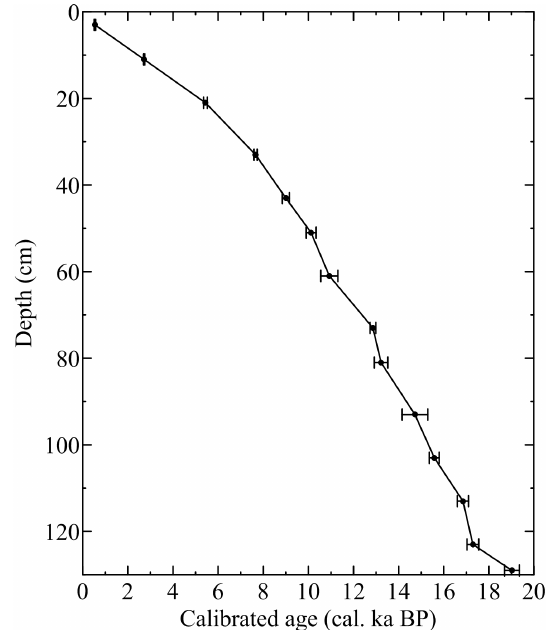
Figure 4. Age–depth model of the SS-4018 sediment core (adopted from Tiwari et al., 2010). The error bars mark 1 σ uncertainty in the calibrated